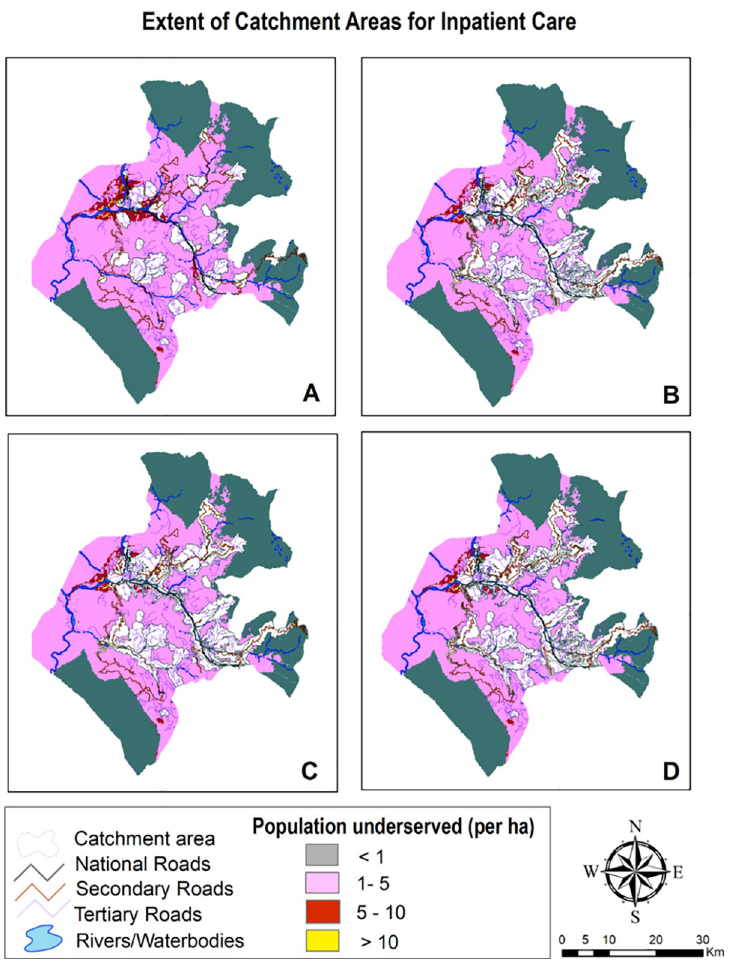
Fig 9. Mapping coverage for inpatient care (2 hour travel